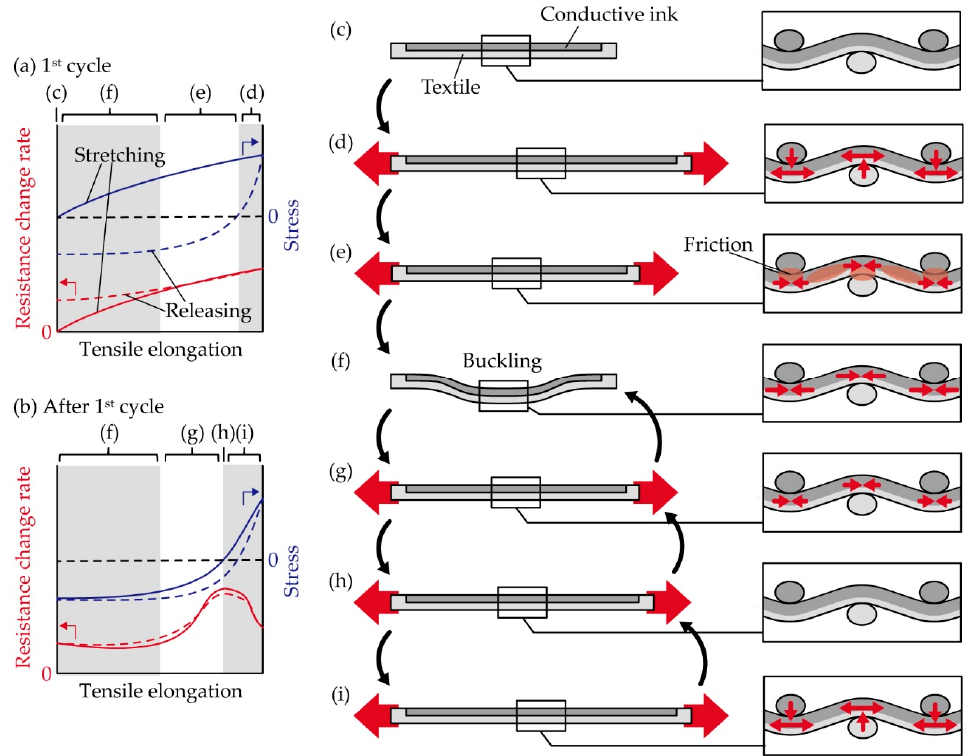
Figure 7. Schematic illustrations of a deformed sample under cyclic tensile deformation. Simplified resistance and stress variation ( a ) during the first cycle and ( b ) after the first cycle. ( c–i ) Schematic illustration of sample and stress caused in the sample.